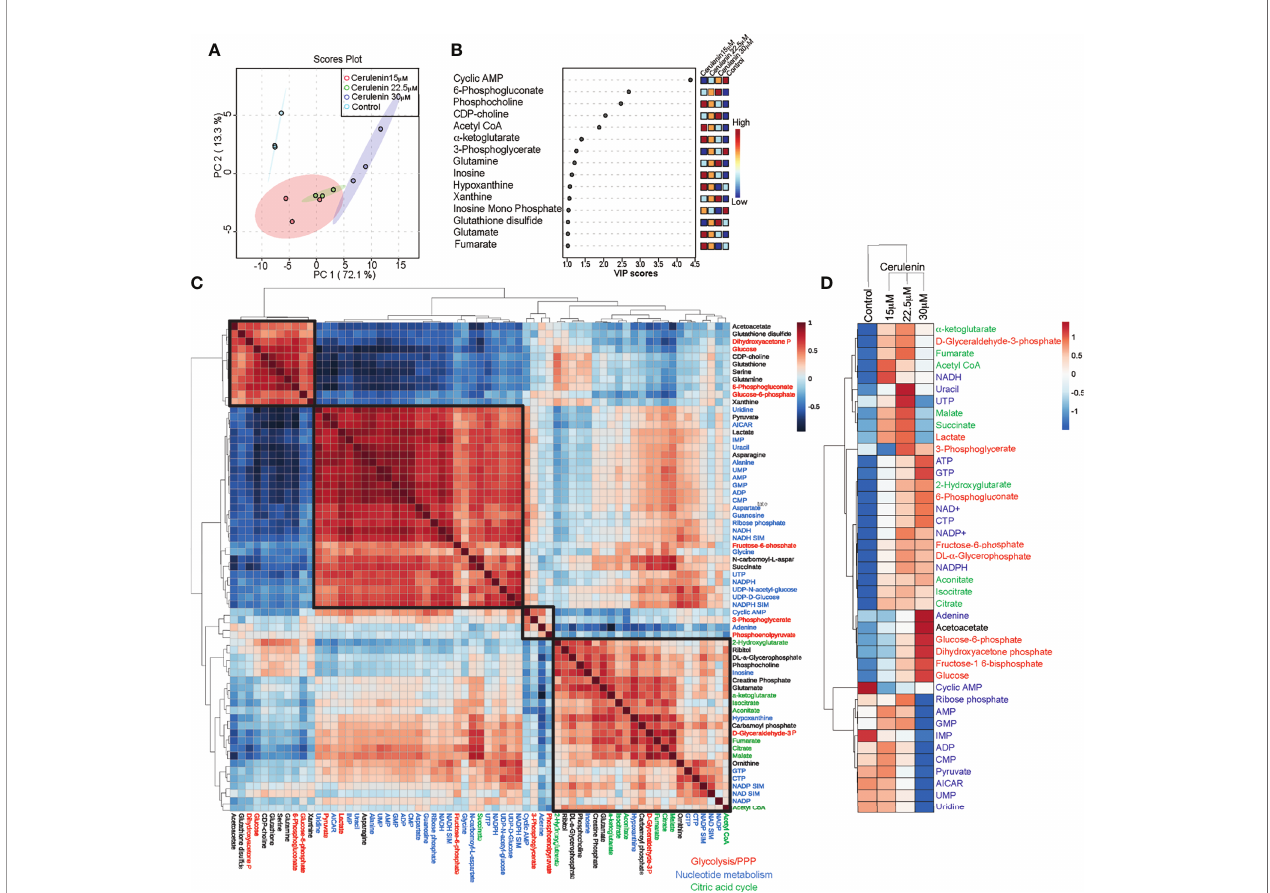
FIGURE 2 | Metabolic impacts of cerulenin-mediated FASN inhibition in SUDHL10 cells. (A) Score plot from SUDHL10 cells by principal component analysis (PCA) indicates variances (shown within brackets) to metabolic pro fi les resulting from cerulenin treatment. (B) Identi fi cation of top signi fi cant metabolite features ( P < 0.001) which contributed to differential PCA loading by partial least squares — discriminant analysis and variable importance in projection scoring analysis. The colored boxes on the right indicate the relative concentrations of the corresponding metabolite in each group. (C) Correlation heat map comparing the top 50 signi fi cant features with p -value and false discovery rate <0.05 determined by one-way ANOVA and post-hoc analysis, identi fi ed distinct patterns of correlative associations (distance measured by Spearman rank correlation) between metabolites affected by cerulenin treatment in SUDHL10 cells. In the correlation matrix, a positive correlation coef fi cient between concordant metabolites is represented in red, and a negative correlation coef fi cient between discordant metabolites is represented as blue. Legend depicting the metabolites shown in colors represents the following: red — glucose metabolism, blue — nucleotide metabolism, and green — citric acid cycle. (D) Heat map representing hierarchical clustering by correlation distance and average linkage of log 2 -transformed; row-centered data show cerulenin dose effect on individual metabolite in experimental triplicates, indicating either increased (in red) or decreased (in blue) pool sizes observed with FASN inhibition in SUDHL10